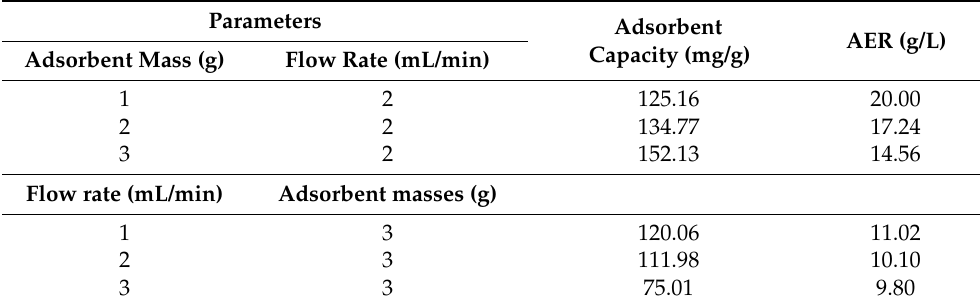
Table 6. Parameters for fixed-bed adsorption of Cr(VI) on MNPs/rGO/PMMA at breakthrough